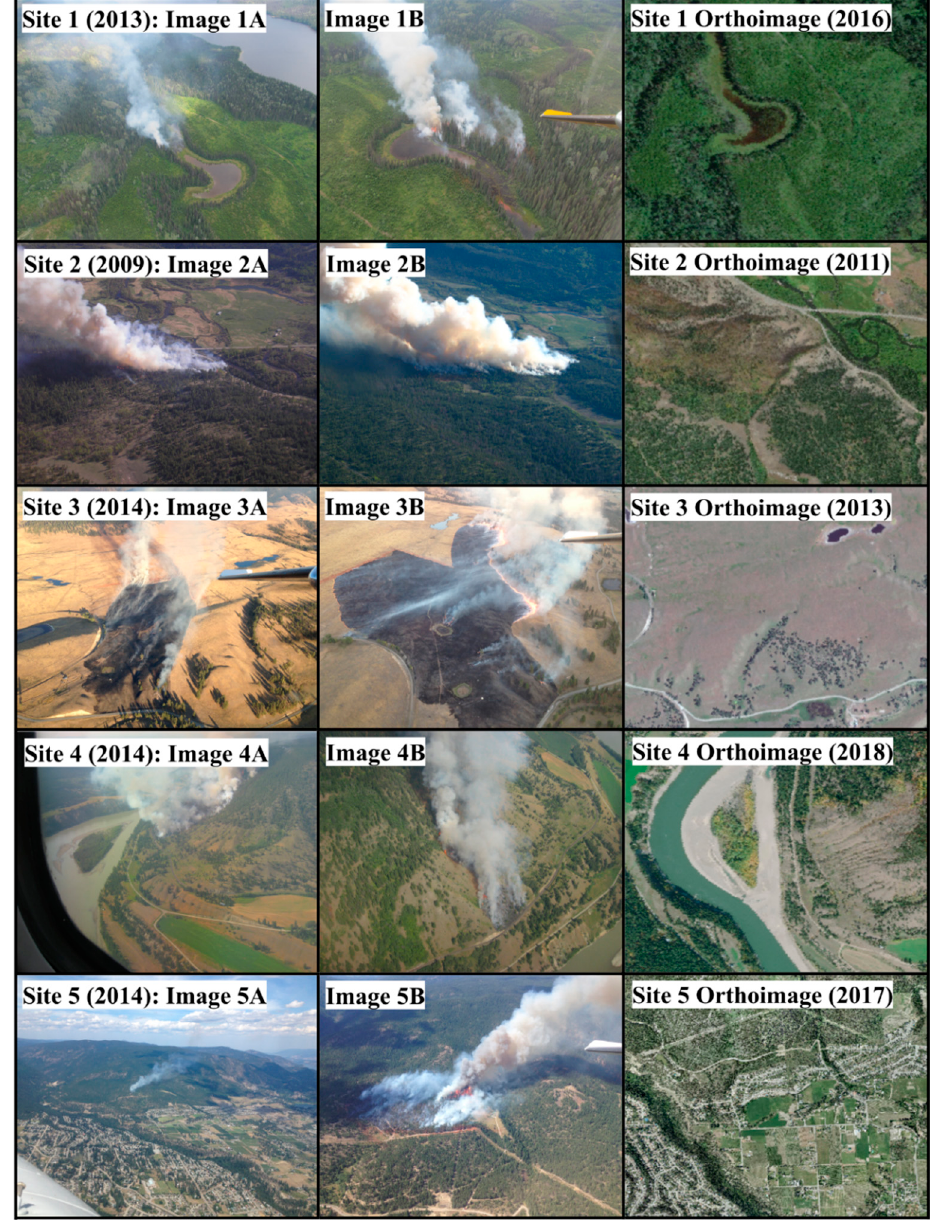
Figure 4. Study site image pairs with their respective orthoimages. Images were captured at